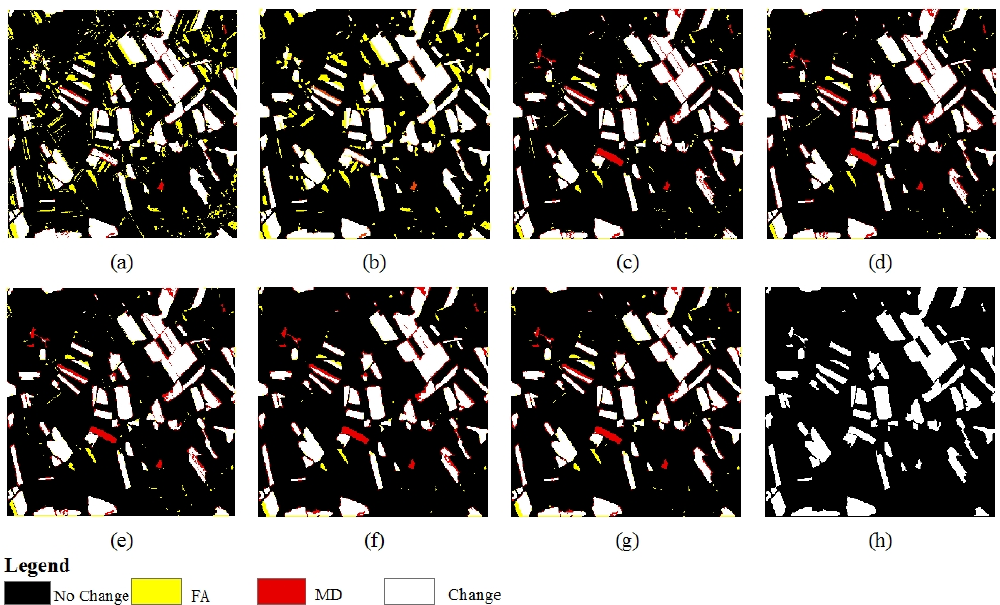
Figure 10. Final change detection maps of the Liaoning dataset produced by ( a ) EM; ( b ) EMMRF;